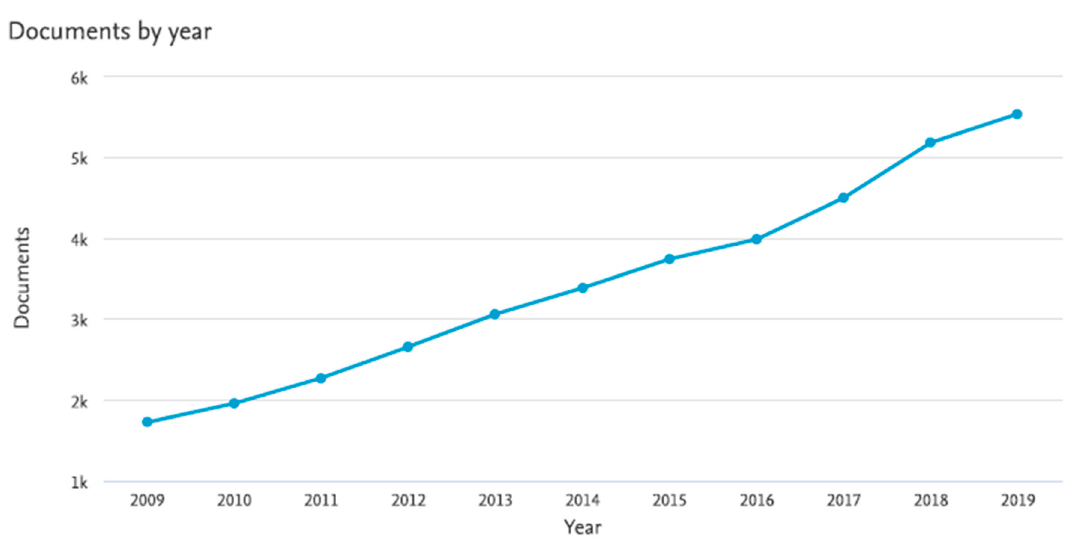
Figure 1. Results analysis for Scopus query “novel foods” in title, keywords or abstract section of the articles between 2009 and 2019.